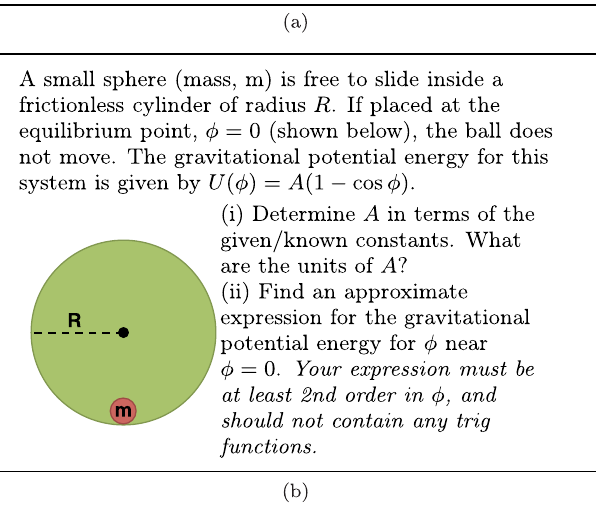
FIG. 4 (color online). Students’ solutions to these Taylor series exam problems were analyzed using the ACER framework. (a) Motion problem developed prior to ACER. (b) Energy prob- lem developed after ACER and used as part of interview studies. Italicized text did not appear on interview